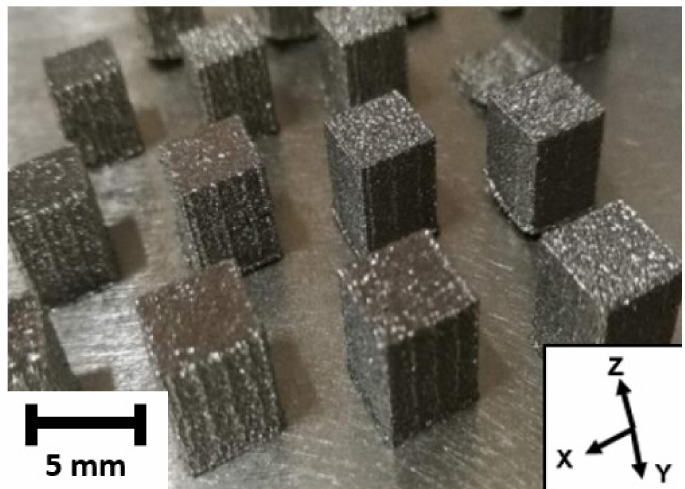
Figure 2. As-fabricated cubes of NiTa.